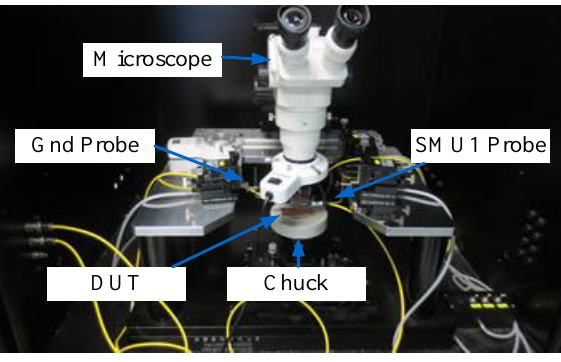
Figure 8. Illustration of Hysteresis I-V characterization setup for memristor behavior.